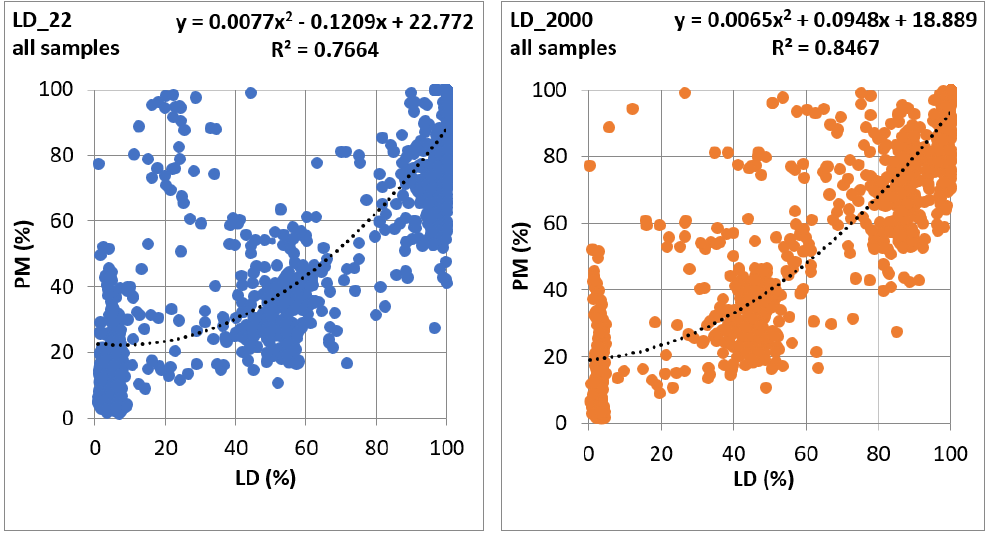
Figure 5. Polynomial regression correlation between pipette method (PM) and laser diffraction method for all soil samples as determined by Analysette22 MicroTec plus (LD_22) and Mastersizer2000 (LD_2000).